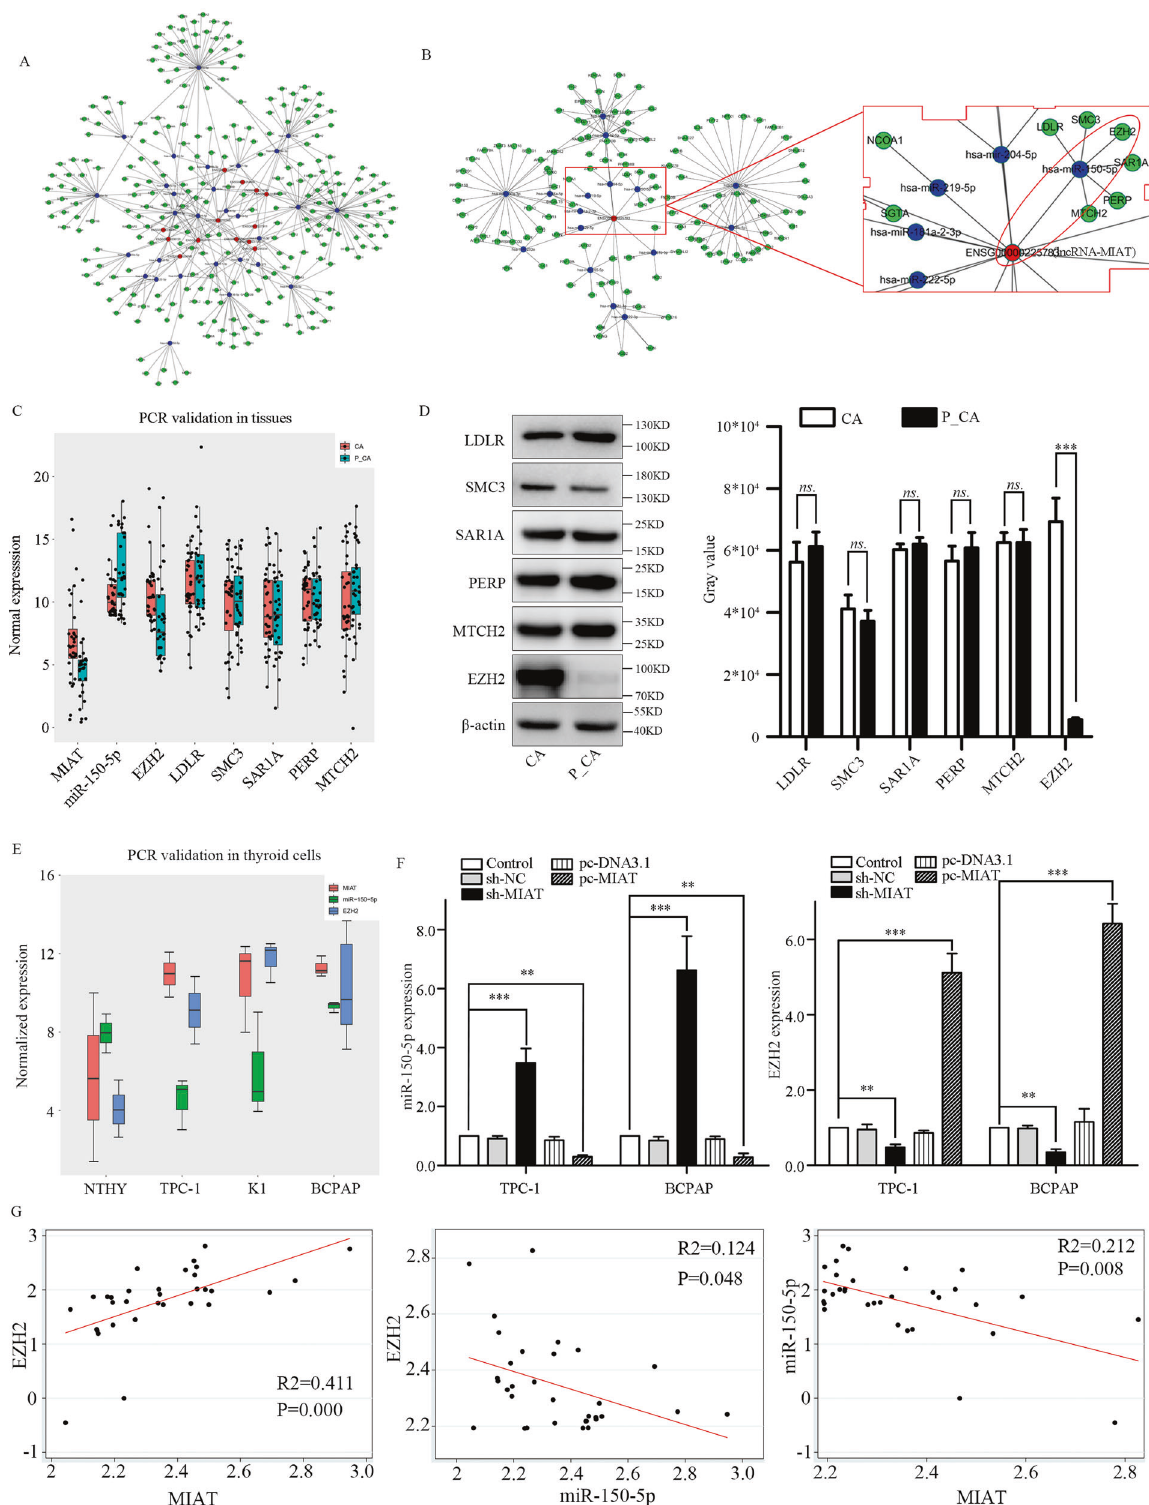
Fig. 3 Interaction among three components of the ceRNA network. A An ceRNA network including 15 lncRNAs, 28 miRNAs, and hundreds of mRNAs were involved. The red dot represented the lncRNA, the blue dot represented the miRNA and the green ones represented the mRNA. B Construction of the ceRNA network demonstrated a relationship among lncRNA-MIAT, miR-150-5p, and EZH2. C MIAT, miR-150-5p and EZH2, LDLR, SMC3, SAR1A, PERP, MTCH2 expression in cancer tissue and para-cancer tissues. D The western blot of EZH2, LDLR, SMC3, SAR1A, PERP, MTCH2 in cancer and para-cancer tissues. E MIAT, miR-150-5p, and EZH2 expression in NTHY, TPC-1, K1, and BCPAP cells. F miR- 150-5p and EZH2 expression in TPC-1 and BCPAP cells when sh-MIAT and pc-MIAT were used. G The Pearson ’ s correlation between lncRNA- MIAT, miR-150-5p, and EZH2 in PTC tissues. * P < 0.05, ** P < 0.01, *** P < 0.001 compared with control cells, n.s. non-signi fi cant, using two-tailed t -test analysis. Cell Death and Disease (2021)